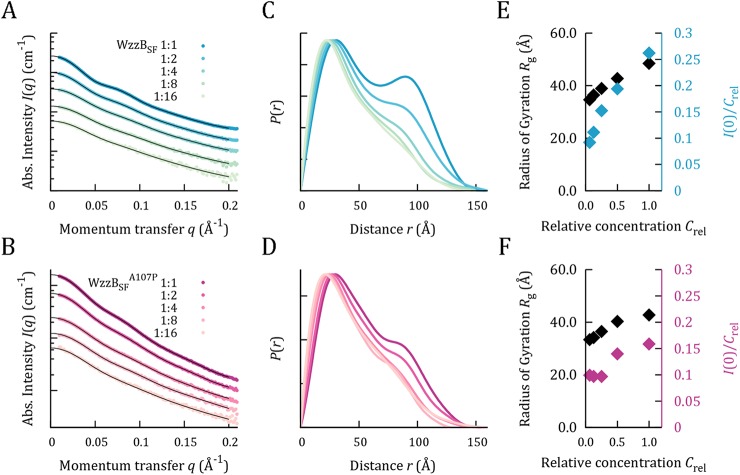
Small-angle X-ray scattering (SAXS) data.(A-B) Averaged and subtracted SAXS data for a dilution series of WzzBSF (A) and WzzBSF
A107P (B), placed on absolute scale by comparison to the scattering of pure water. Data points are shown as circles coloured by dilution. The fits of the corresponding P(r) distributions are shown as black lines. (C-D) Distance distributions calculated from the scattering data by indirect Fourier transformation, showing the frequency, P(r), of intermolecular distances of length r within each particle. Distributions are calculated from each dilution in the concentration series. Plots have been scaled to the maximum of the highest concentration for ease of visualisation. Top panel, WzzBSF; bottom panel, WzzBSF
A107P. Considerable concentration dependence can be observed in both, particularly in the highest concentration of the wild-type protein. (E-F) Analysis of concentration-dependence of particle size and total scattering. Radius of gyration, R
g (black diamonds), and the ratio of zero-angle scattering to concentration, I(0)/Crel (coloured diamonds) are plotted for each dilution of each protein. Both metrics are calculated from Guinier analysis of the low-q region of the data, and would be expected to be stable for a monodisperse, non-interacting species. Approximate non-relative concentrations are 10 mg/ml for 1:1 WzzBSF, and 5 mg/ml for 1:1 WzzBSF
A107P.